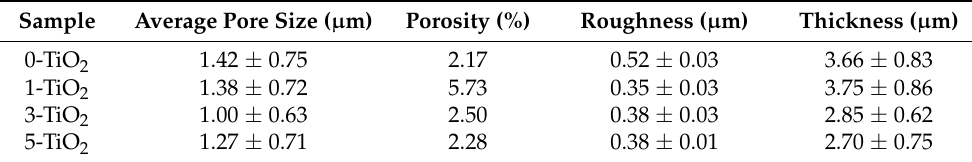
Table 3. The average pore size, porosity percentage, surface roughness, and thickness values of the PEO coatings without and with different concentrations of anatase TiO 2 nanoparticles.